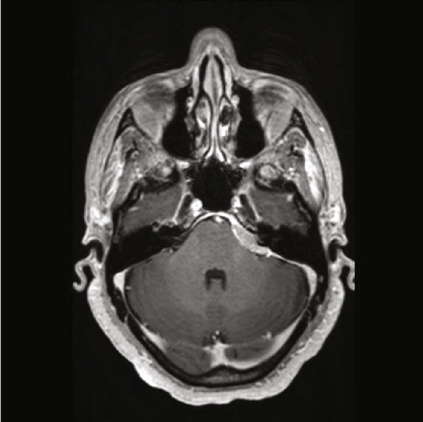
Figure 1: Post contrast MRI demonstrates a well-de fi ned homogeneously enhancing extra-axial dural-based mass in the left CP angle suspicious for an en plaque meningioma.